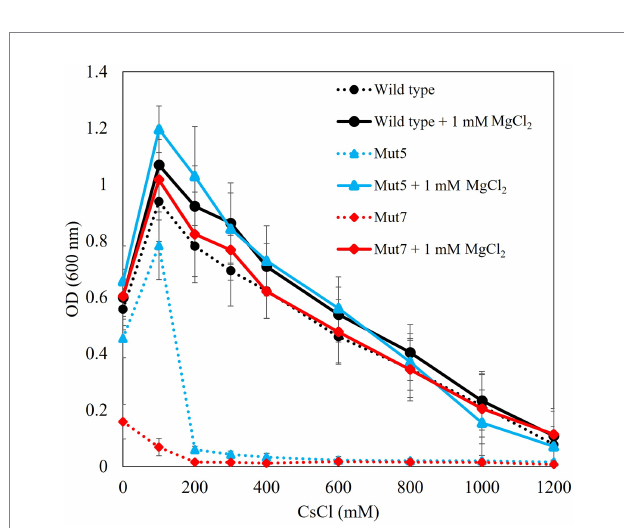
FIGURE 4 Cs + resistance growth test on each strain with and without Mg 2+ addition. Each strain was cultured in Tris medium for 18 h. Dotted line denotes results in the absence of MgCl 2 . Solid line denotes results when 1 mM MgCl 2 was added. Vertical axis indicates turbidity (OD 600 ). Horizontal axis indicates CsCl concentration in the medium. Error bars indicate SD for three independent